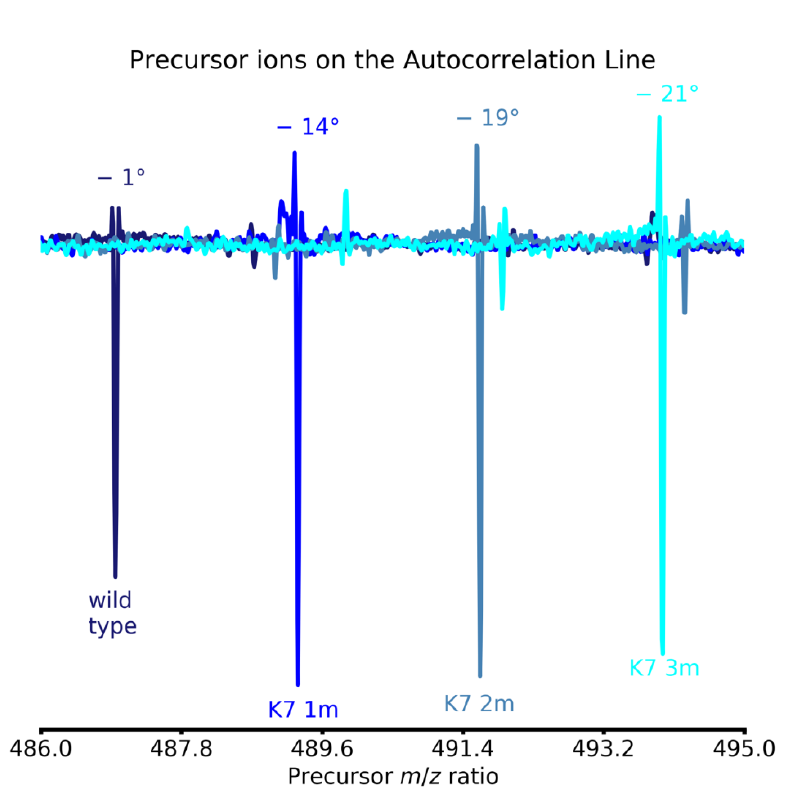
Figure 5. Extracted precursor ion scans for the 12 C isotopes of the four histone peptides from the phase-corrected absorption mode 2D mass